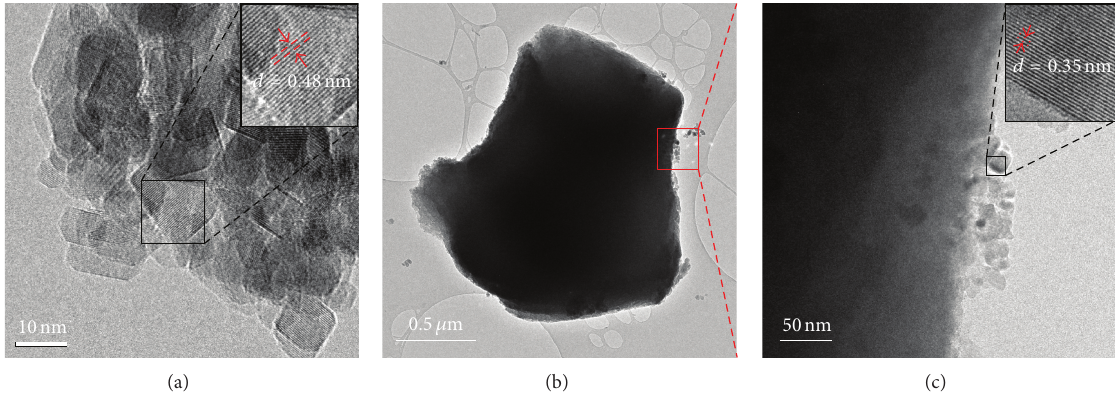
Figure 2: TEM and HRTEM images of TiO 2 (a) and TS composite (b, c). Details on crystallographic planes detected are shown in the inset of (a) and